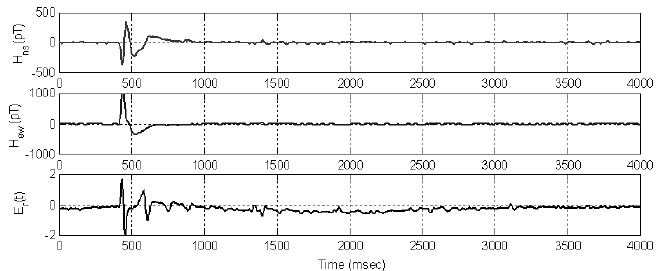
Figure 7 : Example of ELF transient recorded at Mitzpe Ramon (32°N, 34°E) station, Israel.